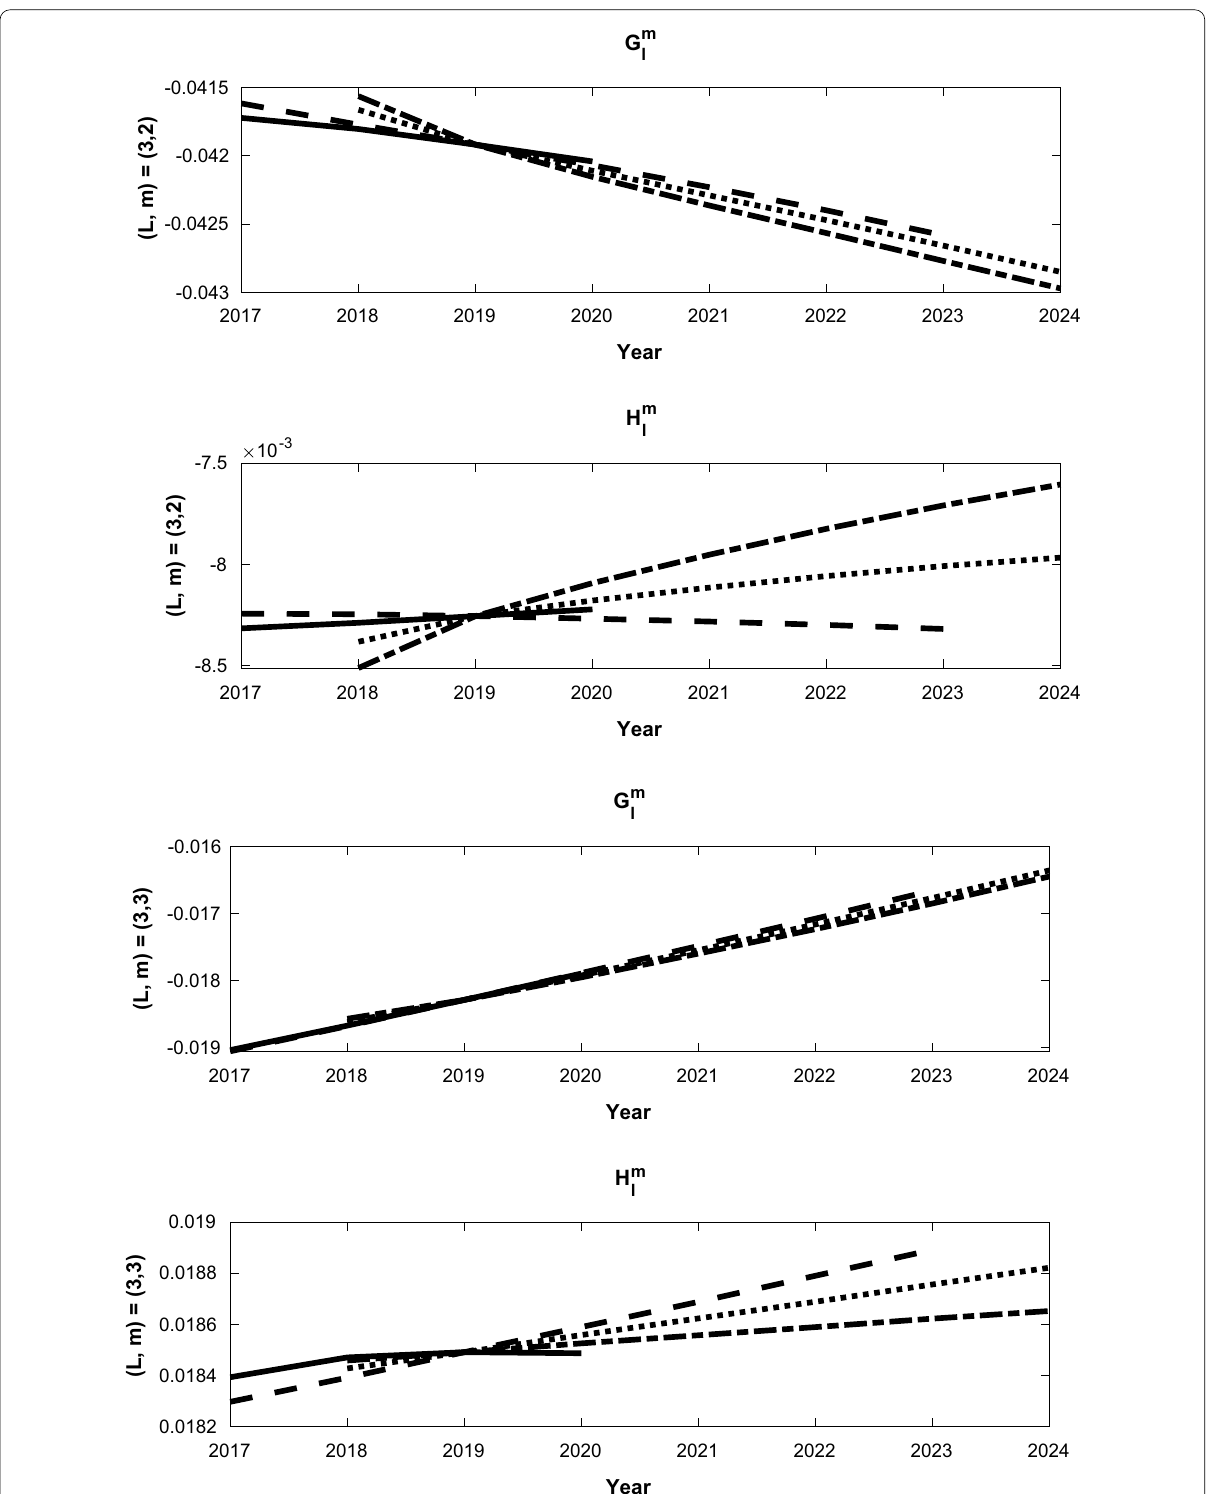
Fig. 5 Same as Fig. 4, except panel ( a ) shows the coefficients for l = 3 and m = 2 , while panel ( b ) shows the coefficients for l = 3 and m =